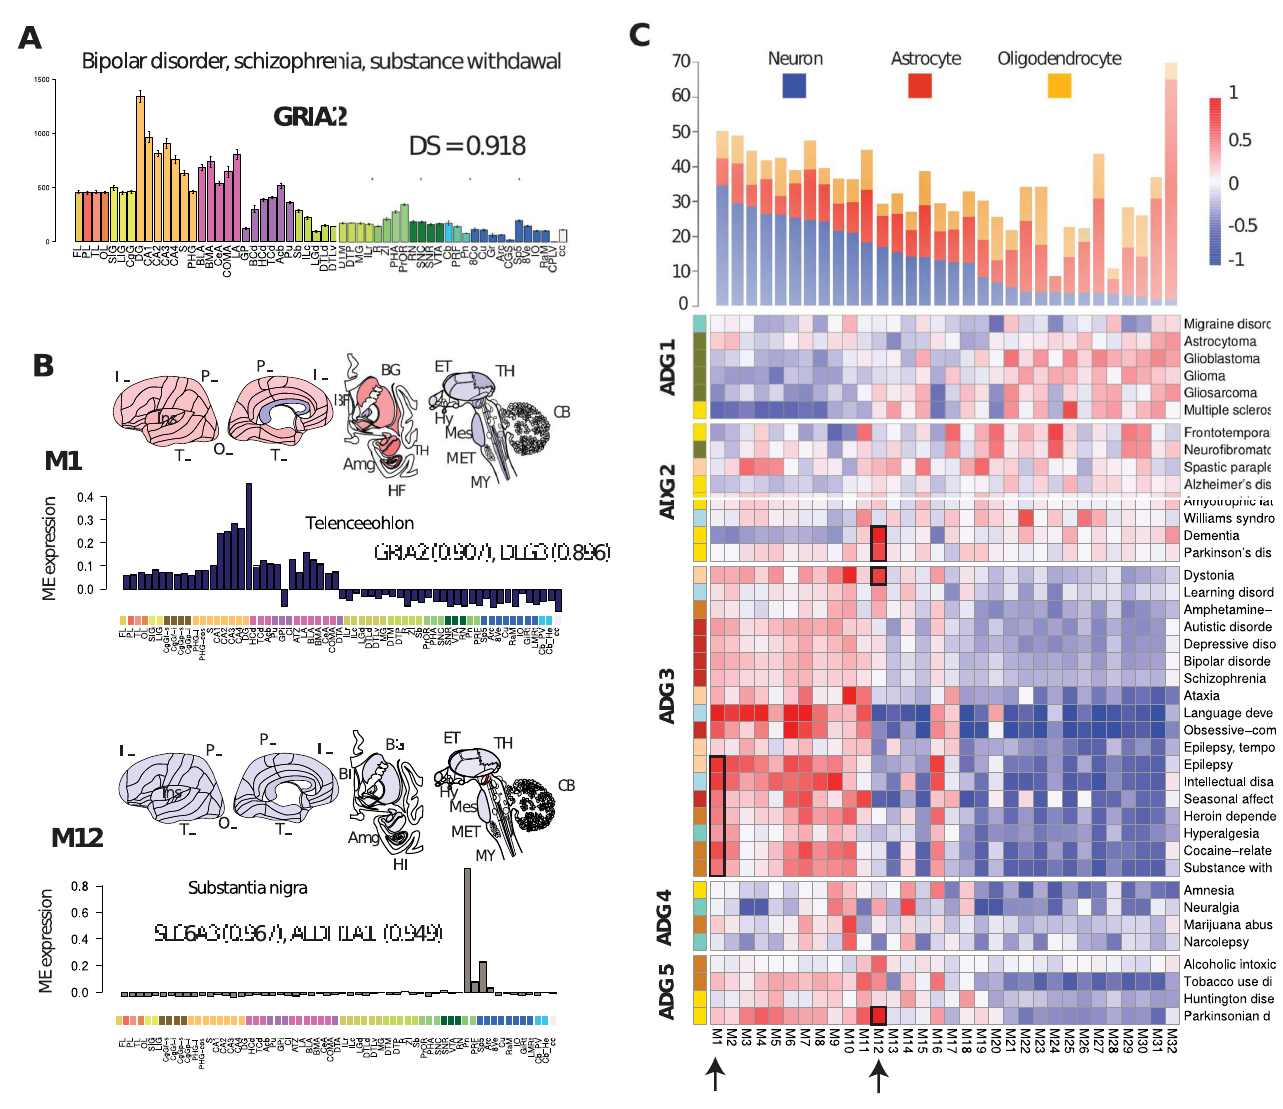
Fig 2. Reproducible transcription patterns in human brain diseases. (A) Expression profile for gene GRIA2 with error bars shown over 56 structures ( S3 Table , human.brain-map.org). DS measures reproducible expression patterns from the AHBA [13]. (B) Canonical eigengenes for M1 telencephalic (language development, epilepsy) and M12 substantia nigra (Parkinson’s disease, dementia), with module correlation for representative genes. (C) Map of canonical expression modules M1 - M32 mapping diseases to anatomic patterns. Disease genes are correlated with each module independently and normalized ( Methods ), disease ordering is the same as in Fig 1 . Modules M1 - M32 are ordered based on their neuronal, astrocyte, oligodendrocyte cell type content derived in [13]. Arrows and boxes indicate diseases overrepresented in M1 and M12 . Other disease representative modules are described in Fig M in S1 Text . Underlying data for Fig 2 can be found in S1 and S5 Tables and the data from S1 Data disease module file. Raw data available at http://human.brain-map.org/. The information for canonical expression modules are available as S6 Table at https://www.nature.com/articles/nn.4171. Code available as a notebook at https://github.com/yasharz/human-brain-disease-transcriptomics. AHBA, Allen Human Brain Atlas; DS, differential stability.